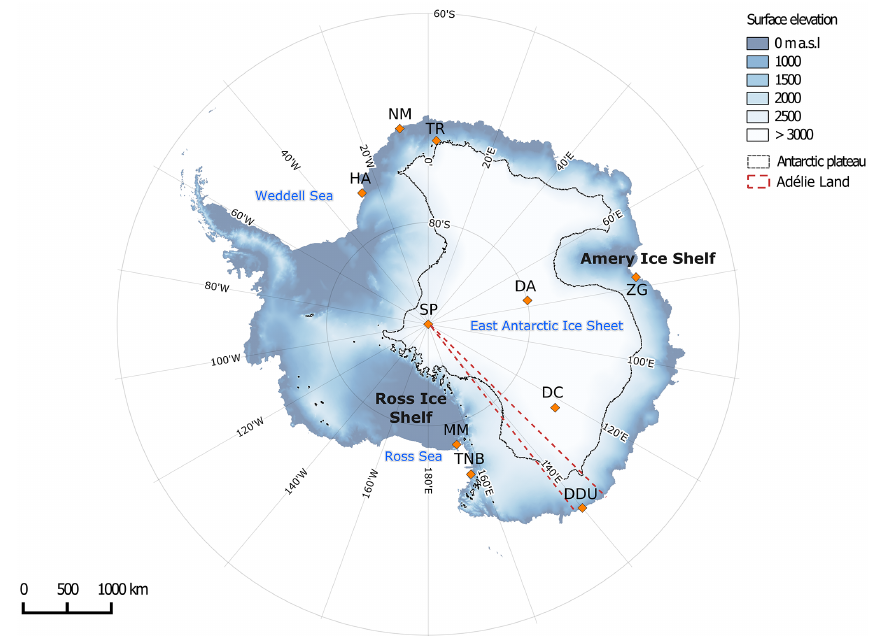
Figure 1. Map of Antarctica showing surface elevation (meters above sea level, ma.s.l.) and the position of various stations: Halley (HA), Neumayer (NM), Troll (TR), Zhongshan Station (ZG), Dome A (DA), South Pole Station (SP), Concordia Station (DC), Dumont d’Urville (DDU), McMurdo (MM), and Terra Nova Bay (TNB). The black line delimits the high altitude plateau (>2500ma.s.l.), and the red dotted line Adélie Land (from 136 to 142 ◦